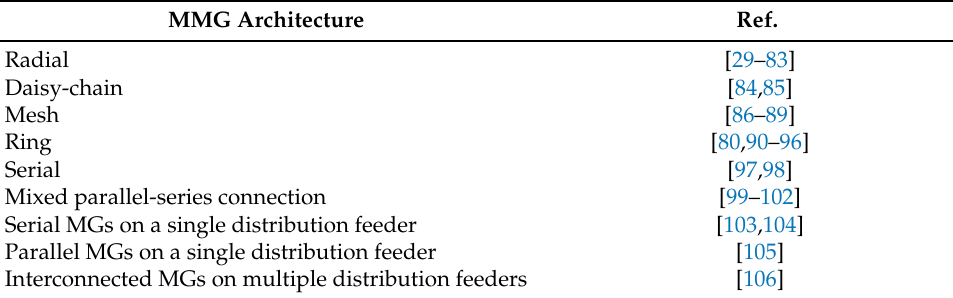
Table 1. Review of MMG architectures reported in the